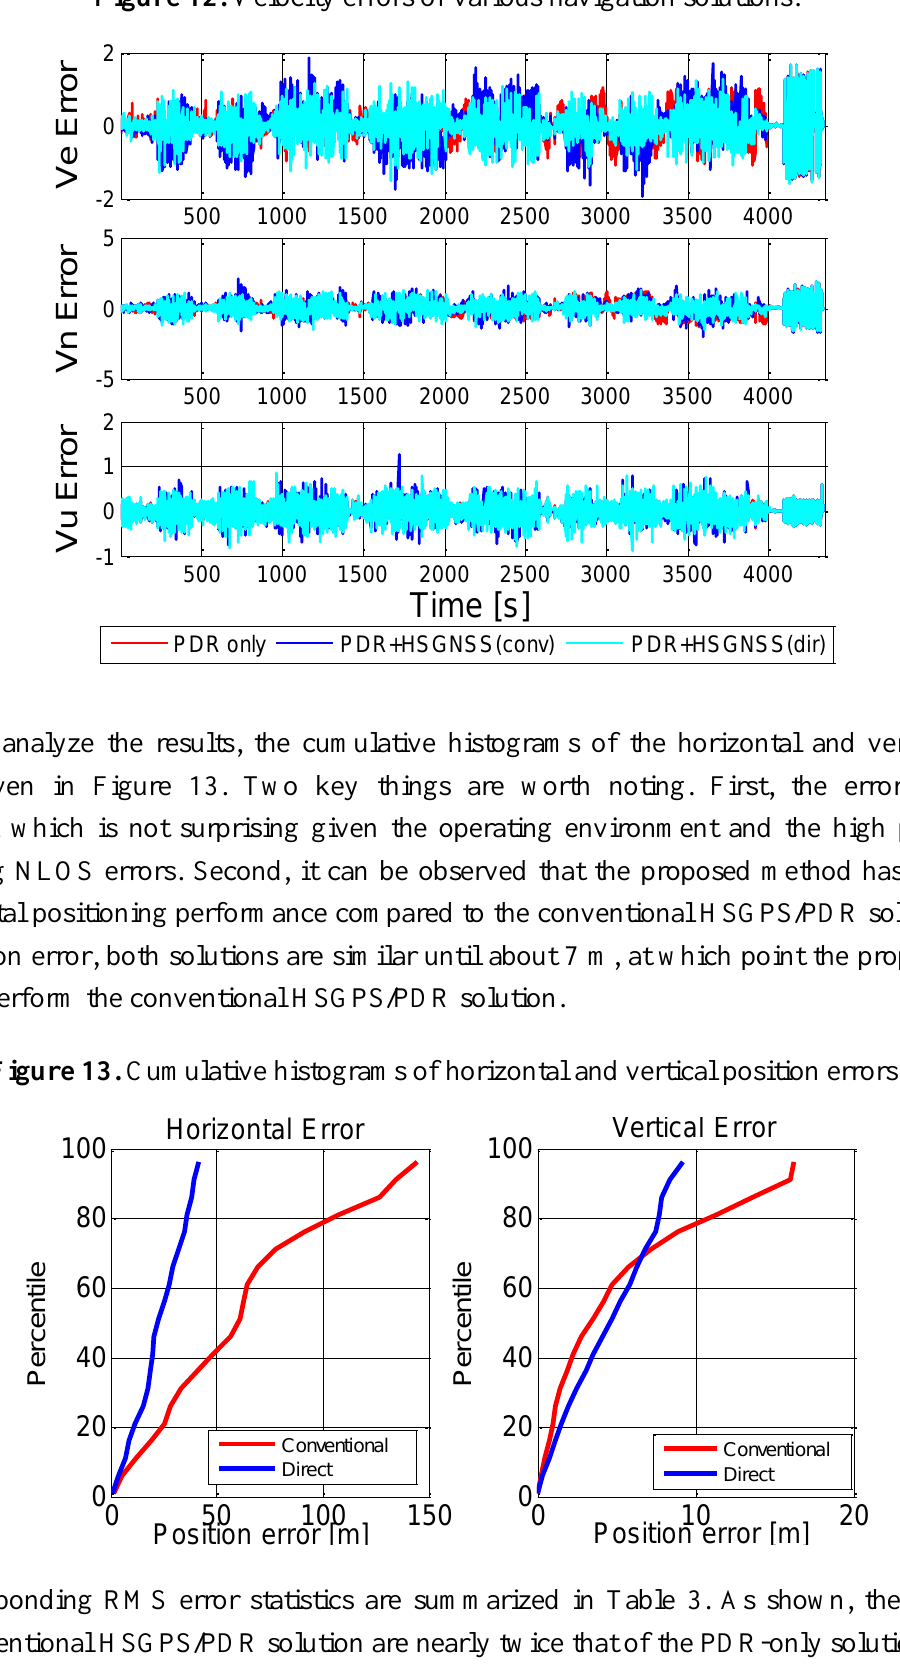
Figure 12. Velocity errors of various navigation solutions.